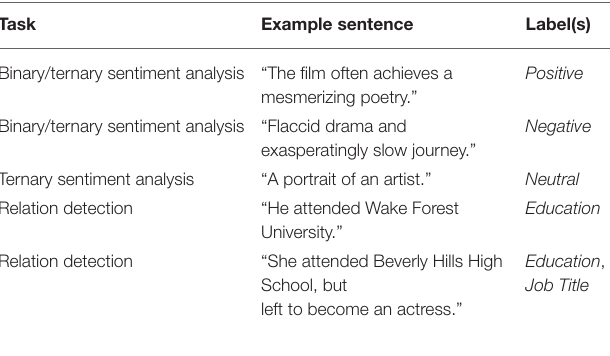
TABLE 2 | Example sentences for all three NLP tasks used in this study. Task Example